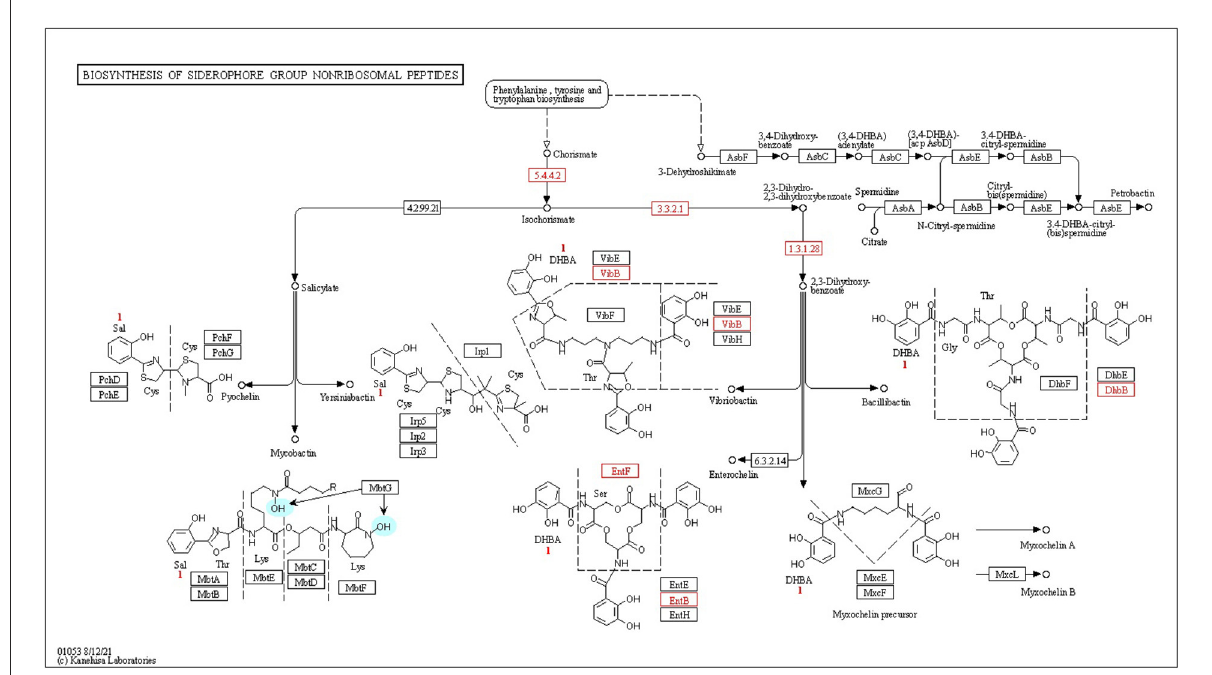
FIGURE6 Kyoto Encyclopedia of Genes and Genomes (KEGG) pathway gene mapping of the strain CPHN2 for siderophore synthesis.